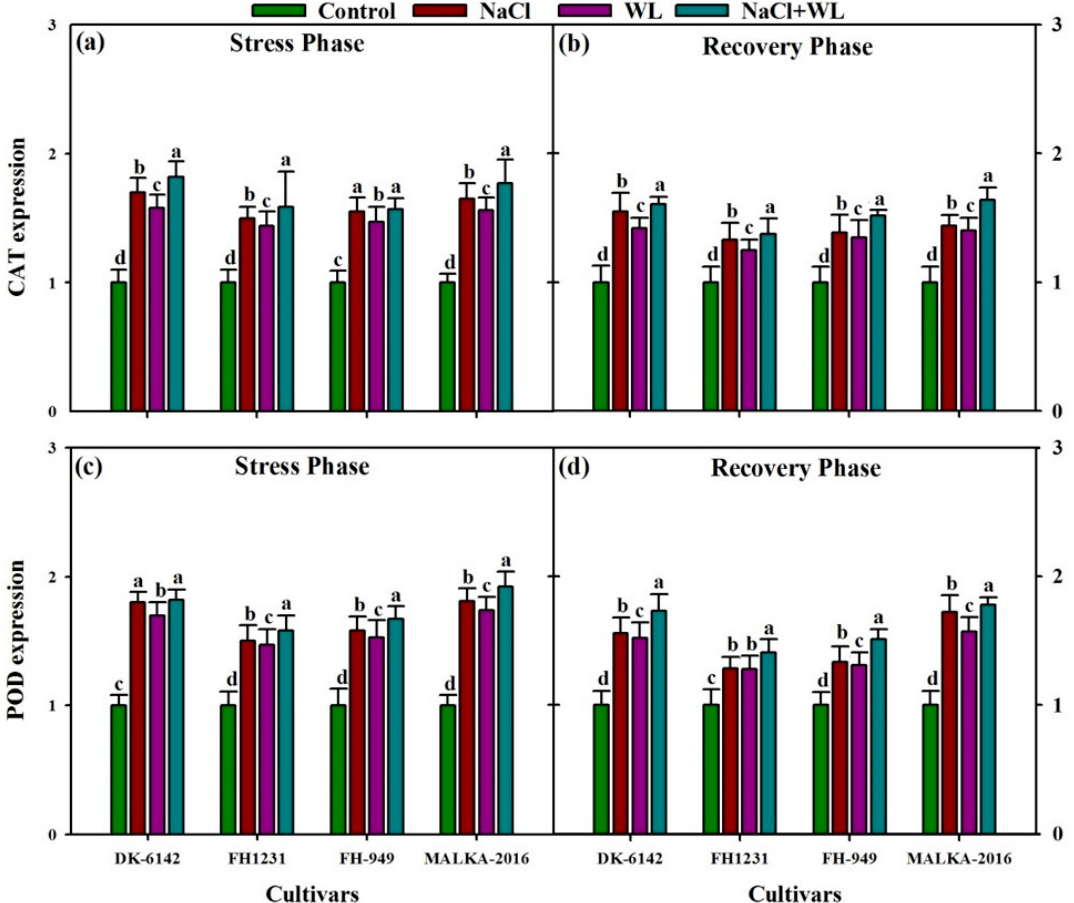
Figure 9. Individual and interactive effects of salinity and waterlogging on the expression of antioxidant enzyme genes including catalase isomer 3 (CAT) and peroxidase 39 isoform X1 (POD) in four maize cultivars during the stress (22 DAS) and recovery (30 DAS) phases. Left and right sides of the figure are representing stress phase and recovery phase respectively. Error bars denote the standard error of three replications. Bars with same letter do not differ significantly at p ≤ 0.05.